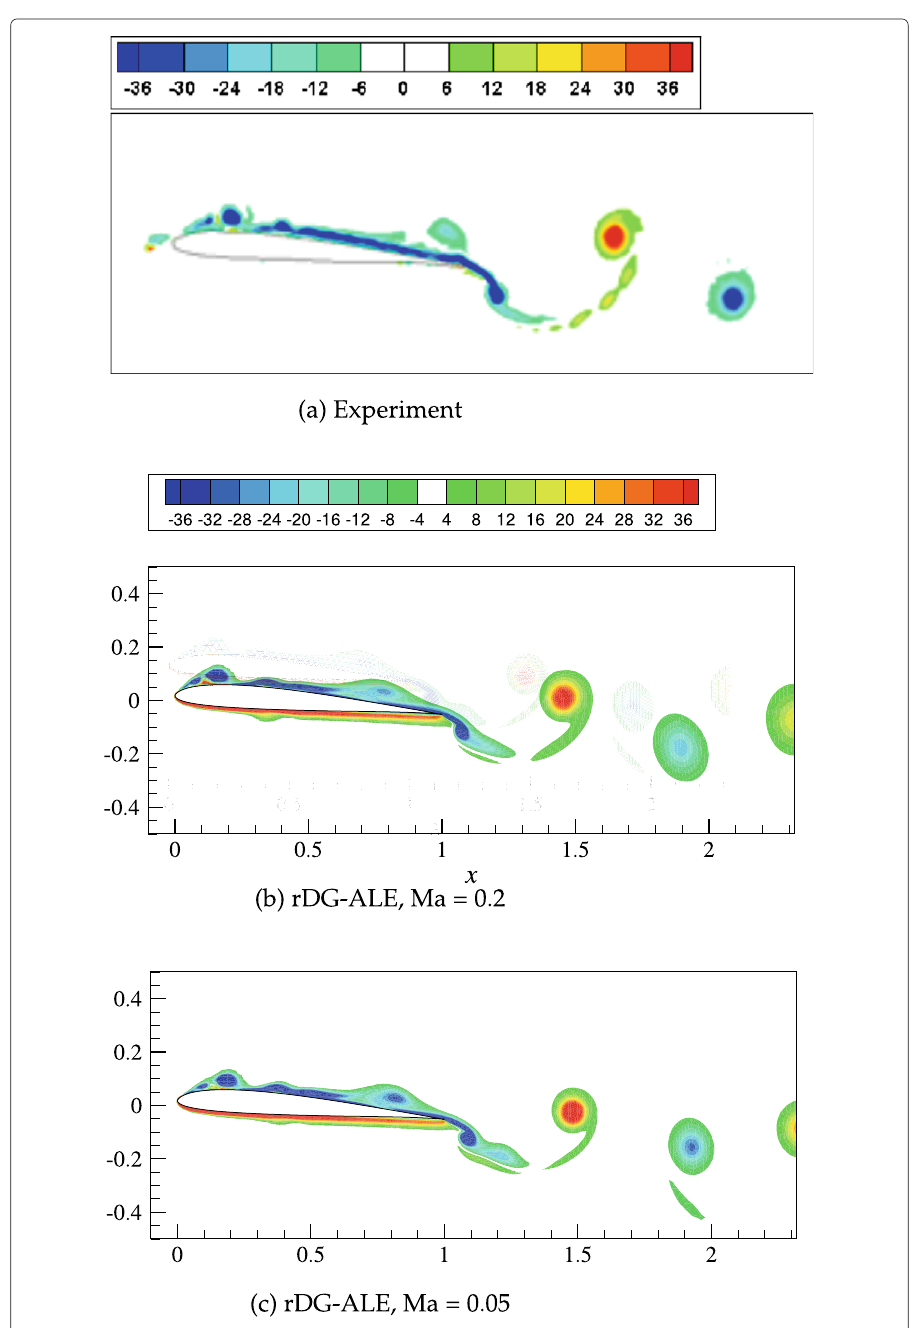
Fig. 17 Comparison of normalized vorticities with experiment at t 0 T for the plunging SD7003